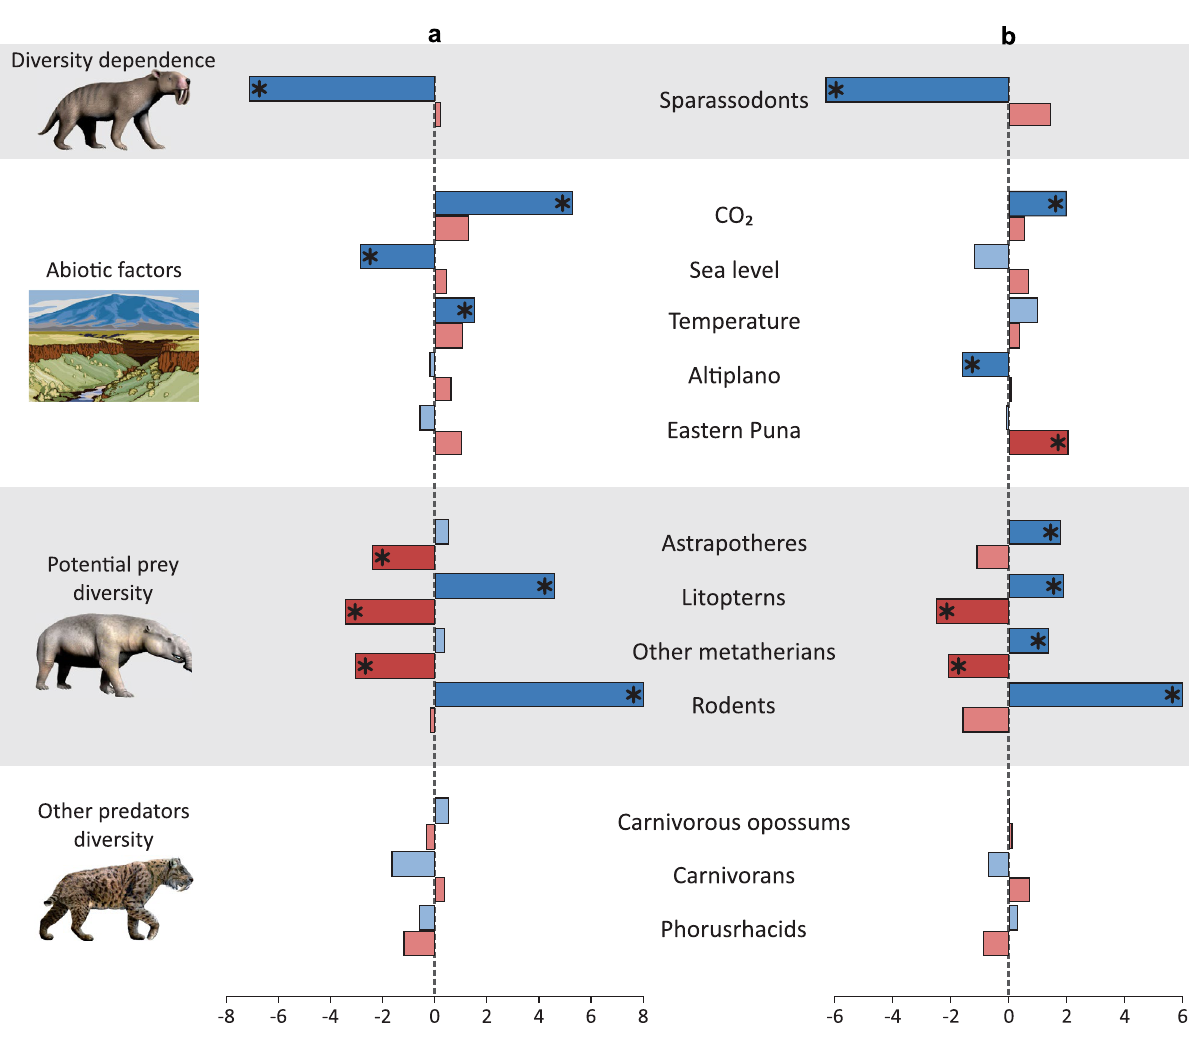
Figure 3. Paleoenvironmental correlations. Correlation parameters for Sparassodonta speciation (G i , in blue) and for Sparassodonta extinction (G m , in red) with the species occurrence dataset ( a ) and the fossil specimens dataset ( b ). Significant correlations (w > 0.5) are indicated by asterisks and darker colours. Landscape illustrated by Gordon Johnson (Pixabay). Thylacosmilus atrox and Astrapotherium magnum designed by Nobu Tamura (Wikimedia Commons) and Smilodon fatalis designed by Dantheman9758 (Wikimedia Commons): https:// creat iveco mmons. org/ licen ses/ by- sa/4.